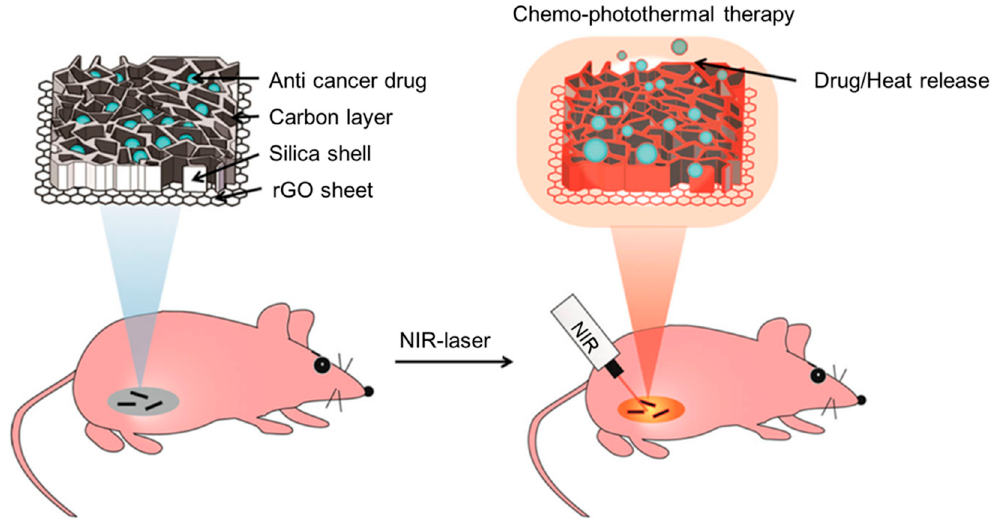
Figure 6. Schematic illustration of chemo-photothermal therapy using reduced graphene ox- ide/carbon/mesoporous silica nanocookies under NIR light-control. Reproduced with permission from ref. [118] Copyright (2014). Wiley-VCH